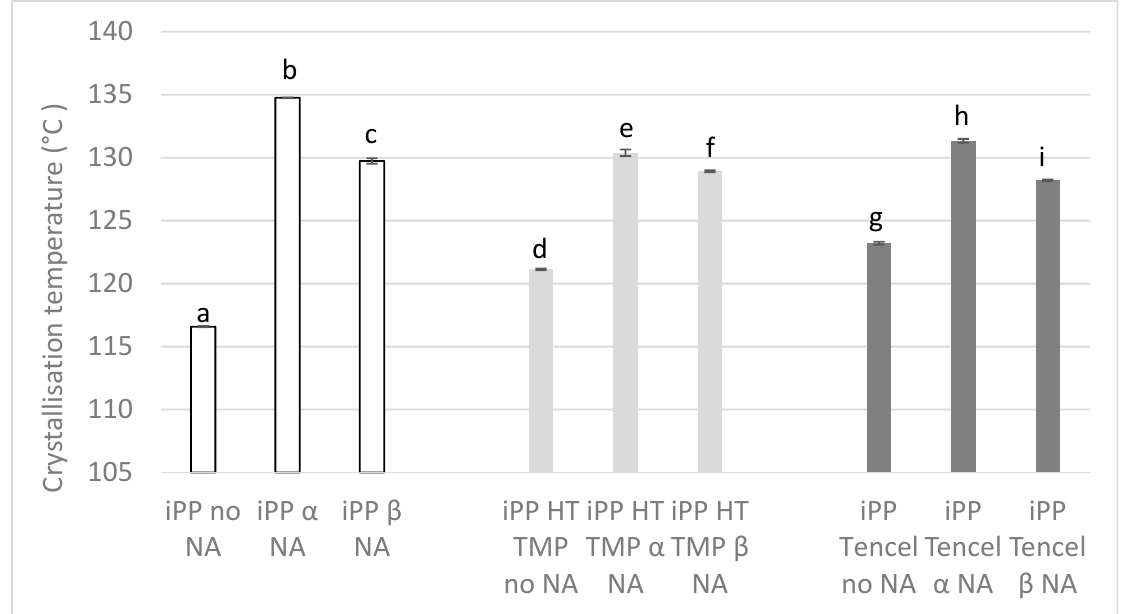
Figure 3. Effect of NA and fibres on iPP crystallisation temperature during a 10 °C min − 1 cooling ramp Figure 3. E ff ect of NA and fibres on iPP crystallisation temperature during a 10 ◦ C min − 1 cooling ramp (n = 3, different letters indicate significant difference at α = 0.05). (n = 3, di ff erent letters indicate significant di ff erence at α =